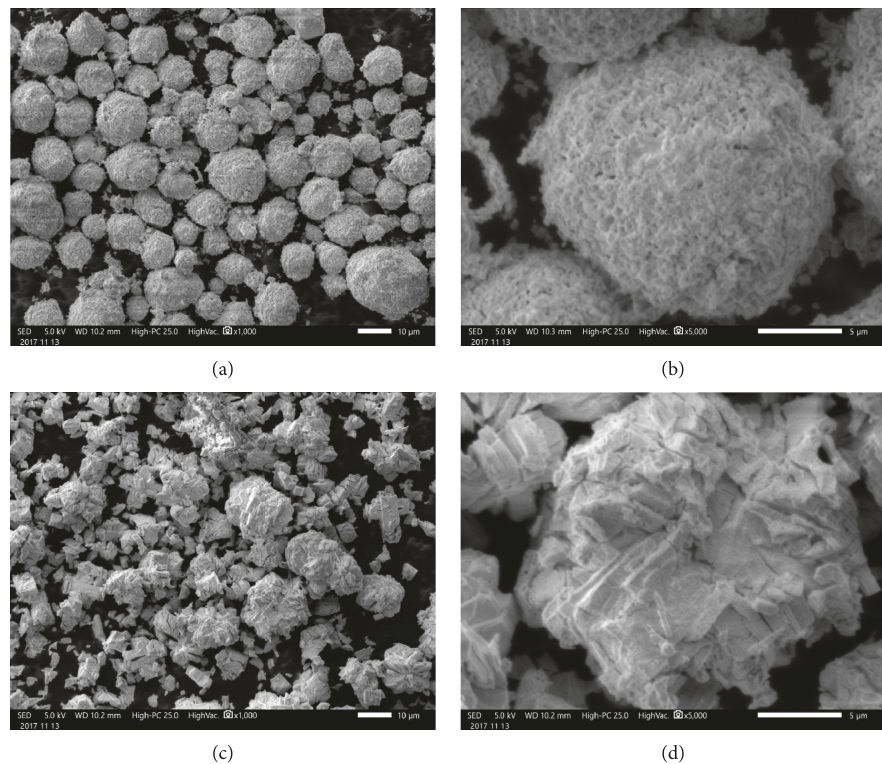
Figure 2: Morphological aspects of rare earth oxides: (a, b) Nd 2 O 3 (AR) and (c, d) rare earth oxides recovered from permanent